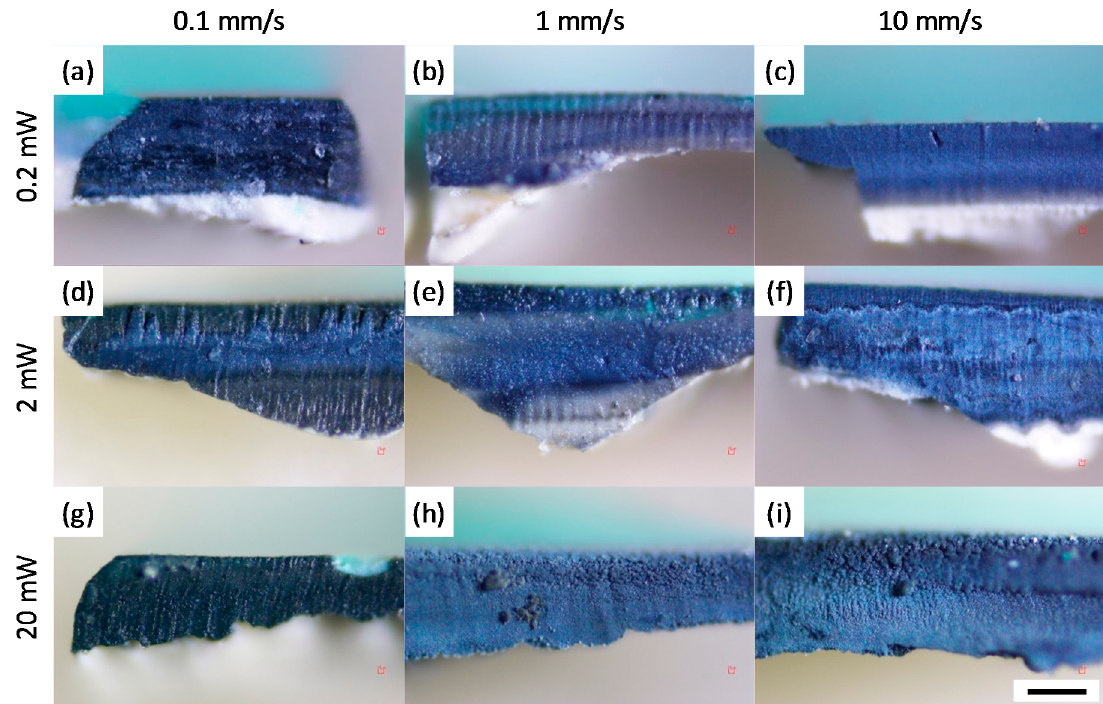
Figure 4. Optical images of sample 2 cross-sections showing effects of translational speeds (0.1, 1 and 10 mm/s—left, middle and right columns, respectively) and input power (0.2, 2 and 20 mW or 0.064, 0.64 and 6.4 J/cm 2 —top, center and bottom rows, respectively) after the femtosecond laser cutting. Inhomogeneous thicknesses of the paint layers are due to roughness of the applied linen canvas. The black scale bar is 100 μ m. Cross-sections in panels ( a – c ) are obtained when changing translational speeds to 0.1, 1 and 10 mm/s, respectively, with a constant input power of 0.2 mW (0.064 J/cm 2 ). Similarly, cross-sections in panels ( d – f ) are obtained under the same range of translational speeds of 0.1, 1 and 10 mm/s, respectively, but the input power is increased to 2 mW (0.64 J/cm 2 ). Input power is further increased to 20 mW (6.4 J/cm 2 ) to obtain cross-sections in panels ( g – i ) under the translational speeds of 0.1, 1 and 10 mm/s, respectively.